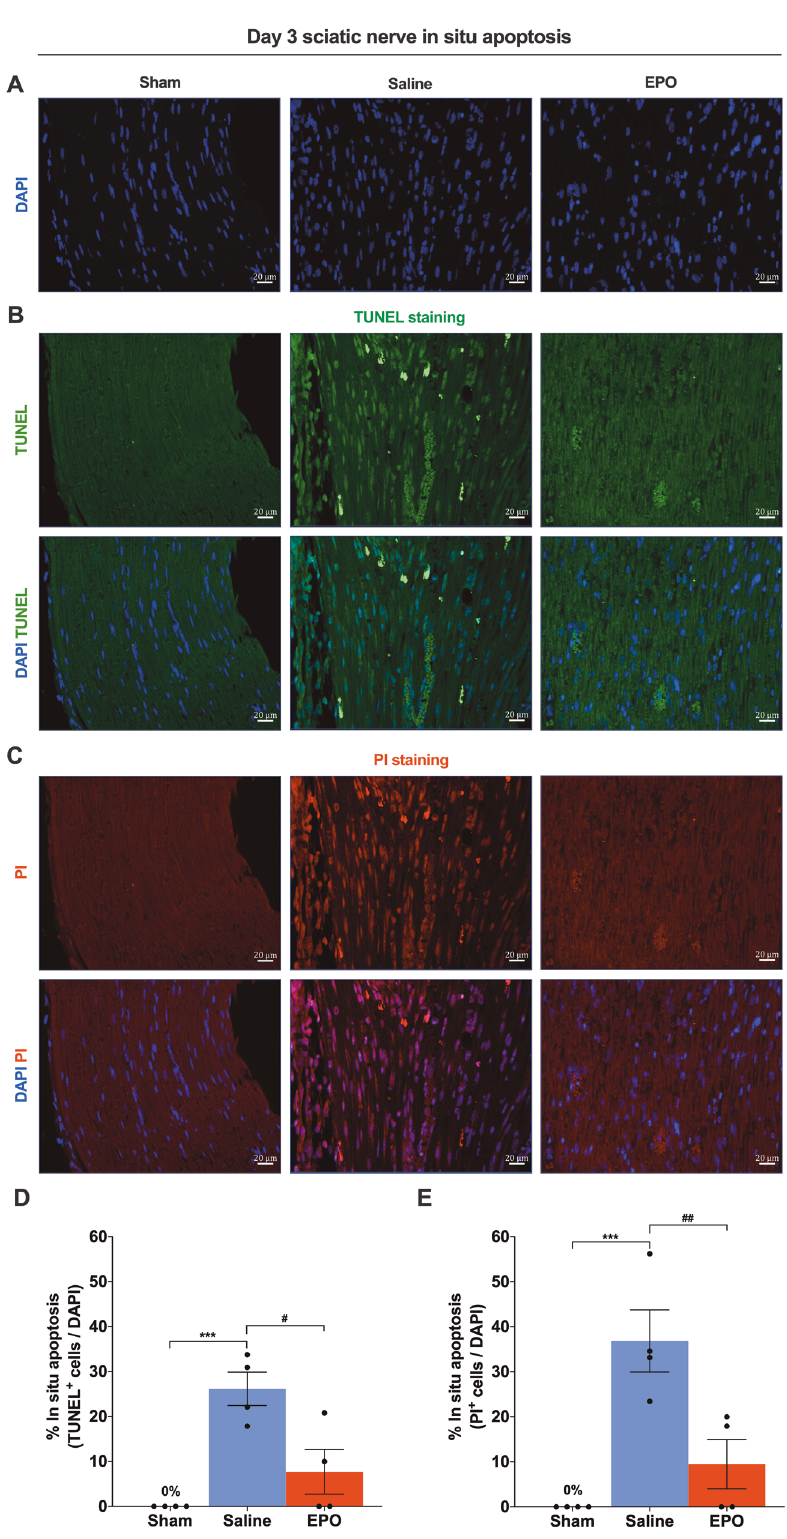
Fig. 1 On day 3, EPO effectively attenuates SN in situ apoptosis following SNCI. A DAPI staining shows cellular in fi ltration of SN. B , C Representative IF images of TUNEL and PI staining of SN shows that EPO treatment (5000 IU/kg/IP, immediately after surgery and on post- surgery day 1 and 2) signi fi cantly attenuates apoptosis as compared to saline treatment (normal saline, 0.1 ml/IP/mouse) and the result of the percentage of in situ apoptosis (TUNEL and PI + /DAPI) are mentioned in the bar graph ( D , E ). SN of Sham animals shows zero percentage of apoptosis. Each image represents six images from four different SN, a total of 24 images/group. Scale bar, 20 μ m; magni fi cation, 40x. One-way ANOVA, Tukey ’ s multiple comparisons test. Data were expressed as means ± SEM, *** P < 0.0002 vs. sham, # P < 0.05 and ## P < 0.0021 vs. Saline, n = 4/group. Cell Death and Disease (2022)